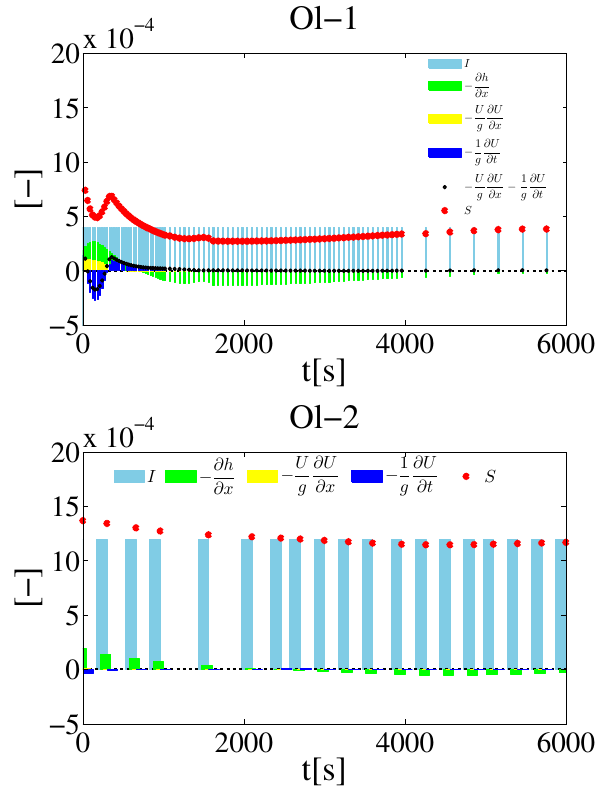
Figure 8. Comparison of terms of the momentum balance equation for experimental flood waves in the Olszanka